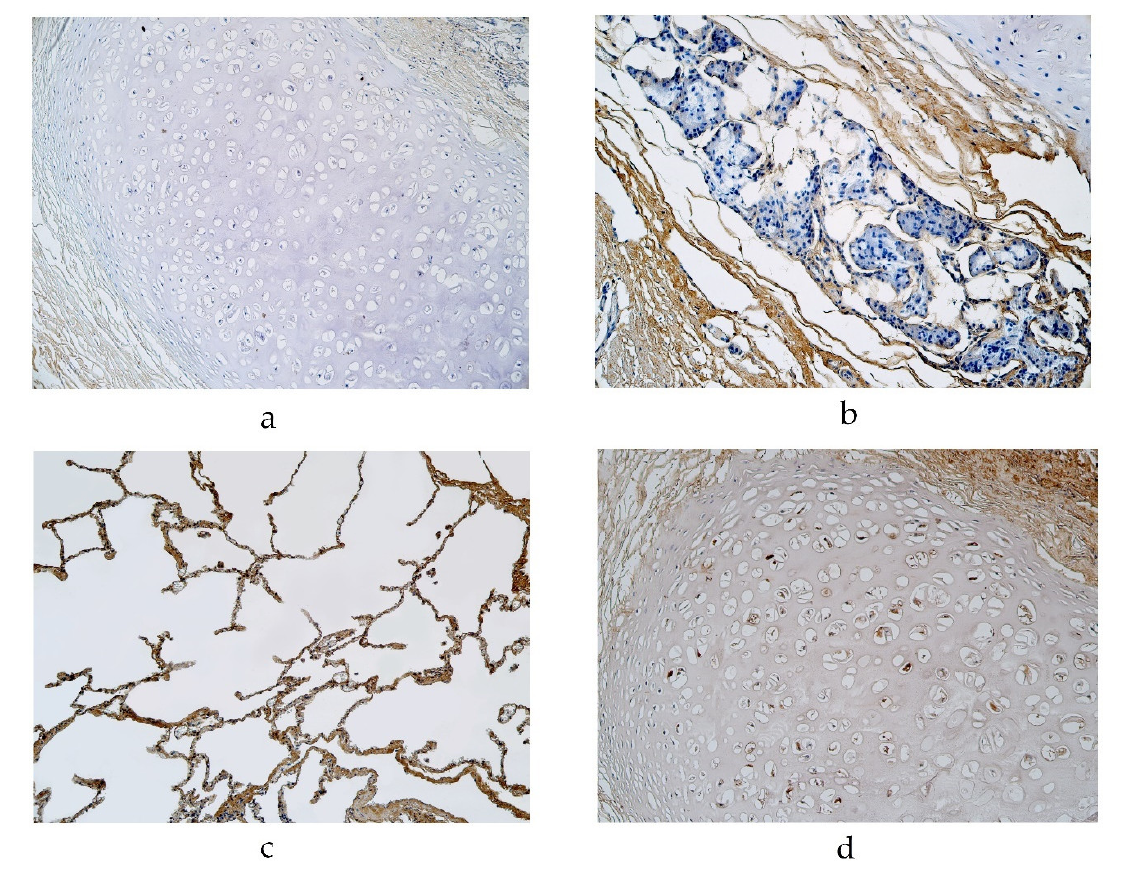
Figure 3. Immunohistochemical micrographs of the lungs. ( a ). Occasional NAPE-PLD positive cartilage in a 56-year-old male in the pseudostratified ciliated epithelium group. NAPE-PLD IMH, X200; ( b ) Occasional NAPE-PLD positive struc- tures in glands of a 94-year-old male in the pseudostratified ciliated epithelium group. NAPE-PLD IMH, X200; ( c ) A few NAPE-PLD positive macrophages and a moderate number of positive alveolar epithelium of a 23-year-old male in the stratified squamous epithelium group. NAPE-PLD IMH, X200; ( d ) A moderate number of positive structures in the carti- lage of a 46-year-old male in the stratified squamous epithelium group. NAPE-PLD IMH,